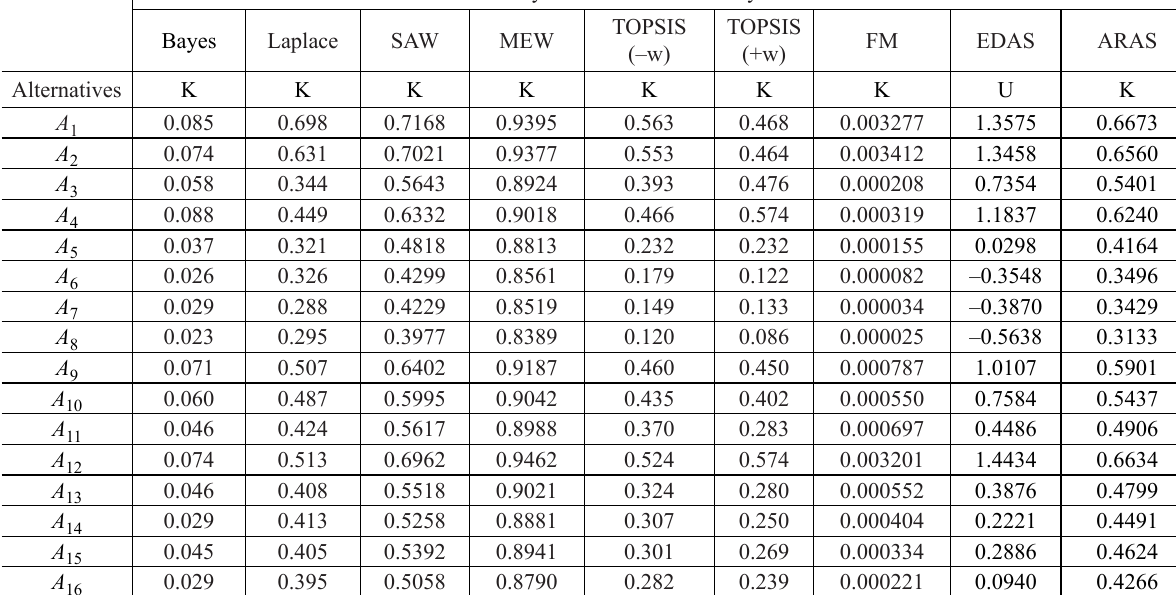
Table 4. Integrated table of results Value of Utility function determined by different methods Bayes Laplace